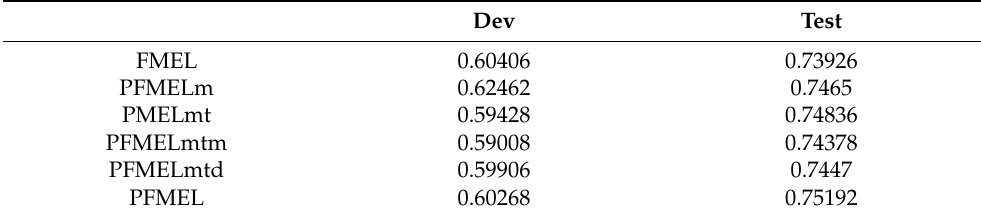
Table 5. Results of ablation study